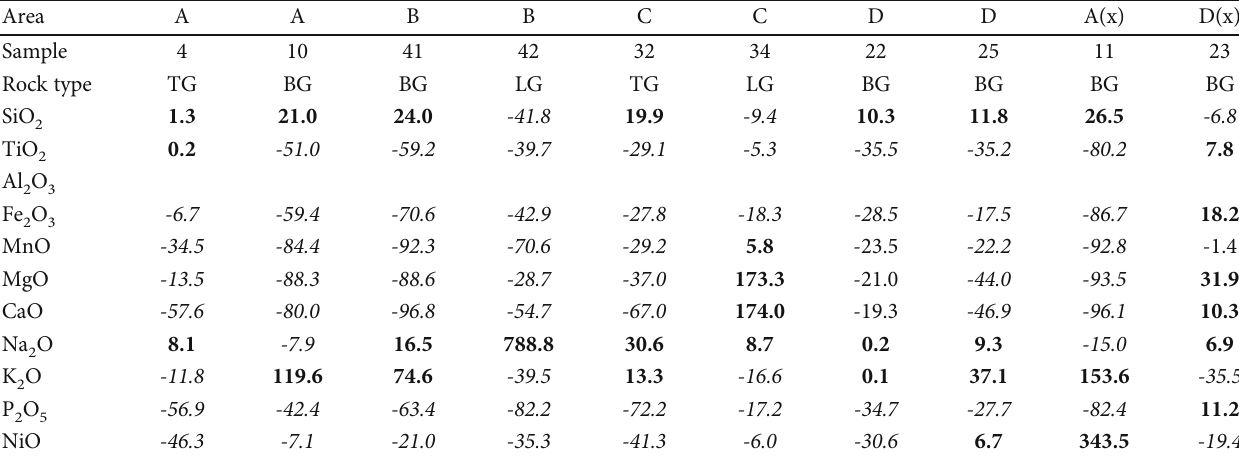
, K O, and Na O. 2 2 2